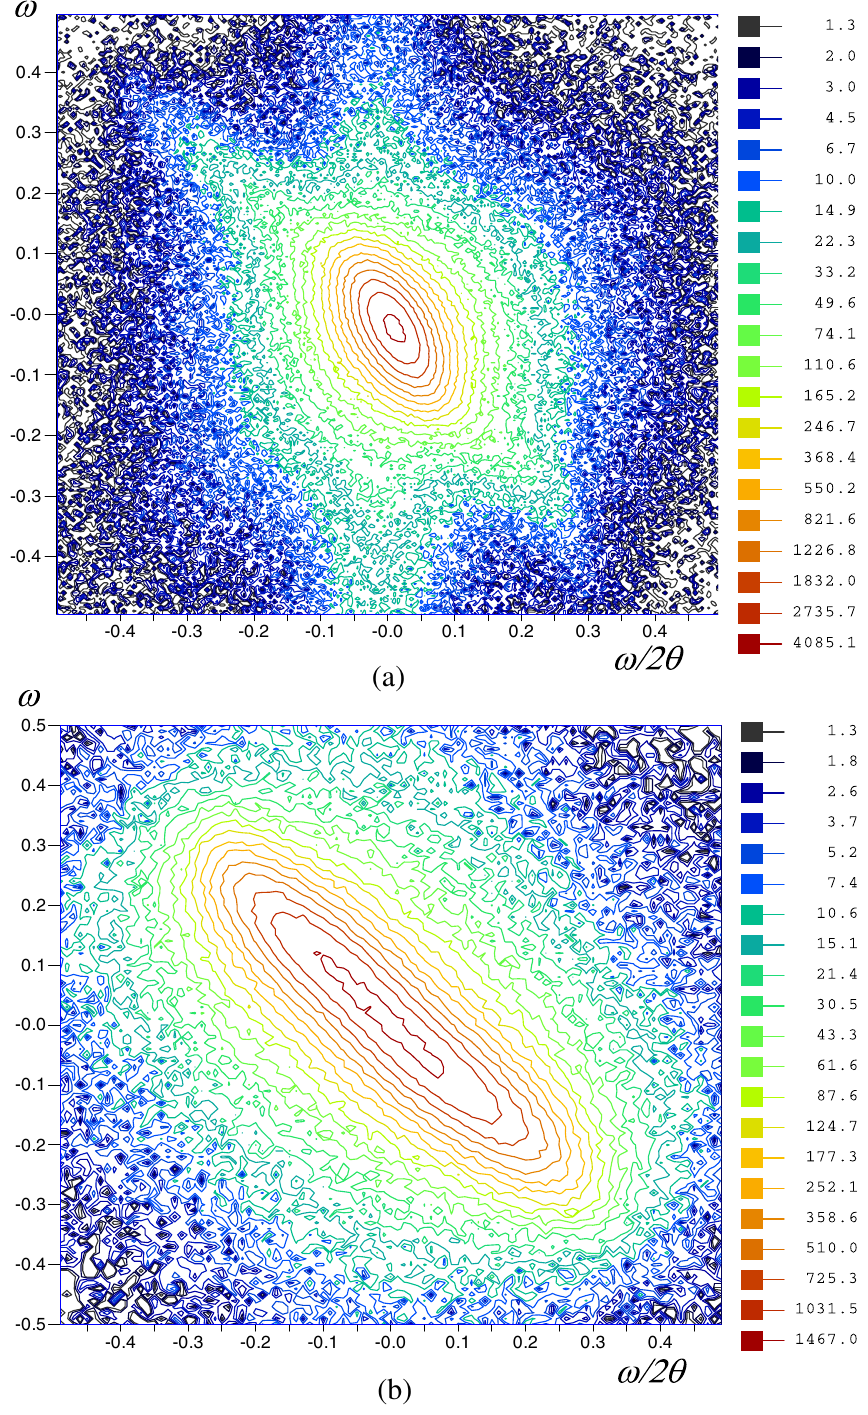
FIG. 3 (color online). RSM experimental plot of Nb film sample CED-034 which shows f 123 g reciprocal points at different x-ray penetration depth: (a) shallow penetration; (b) deep